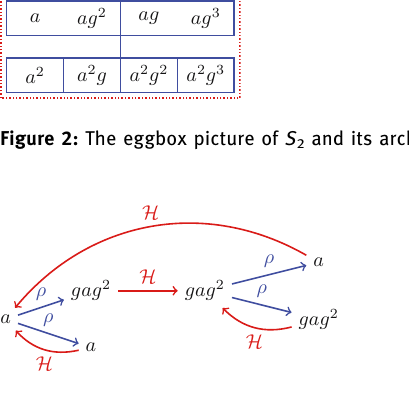
Figure 3: The sequence of transitions of a under the relation ρ on S 1